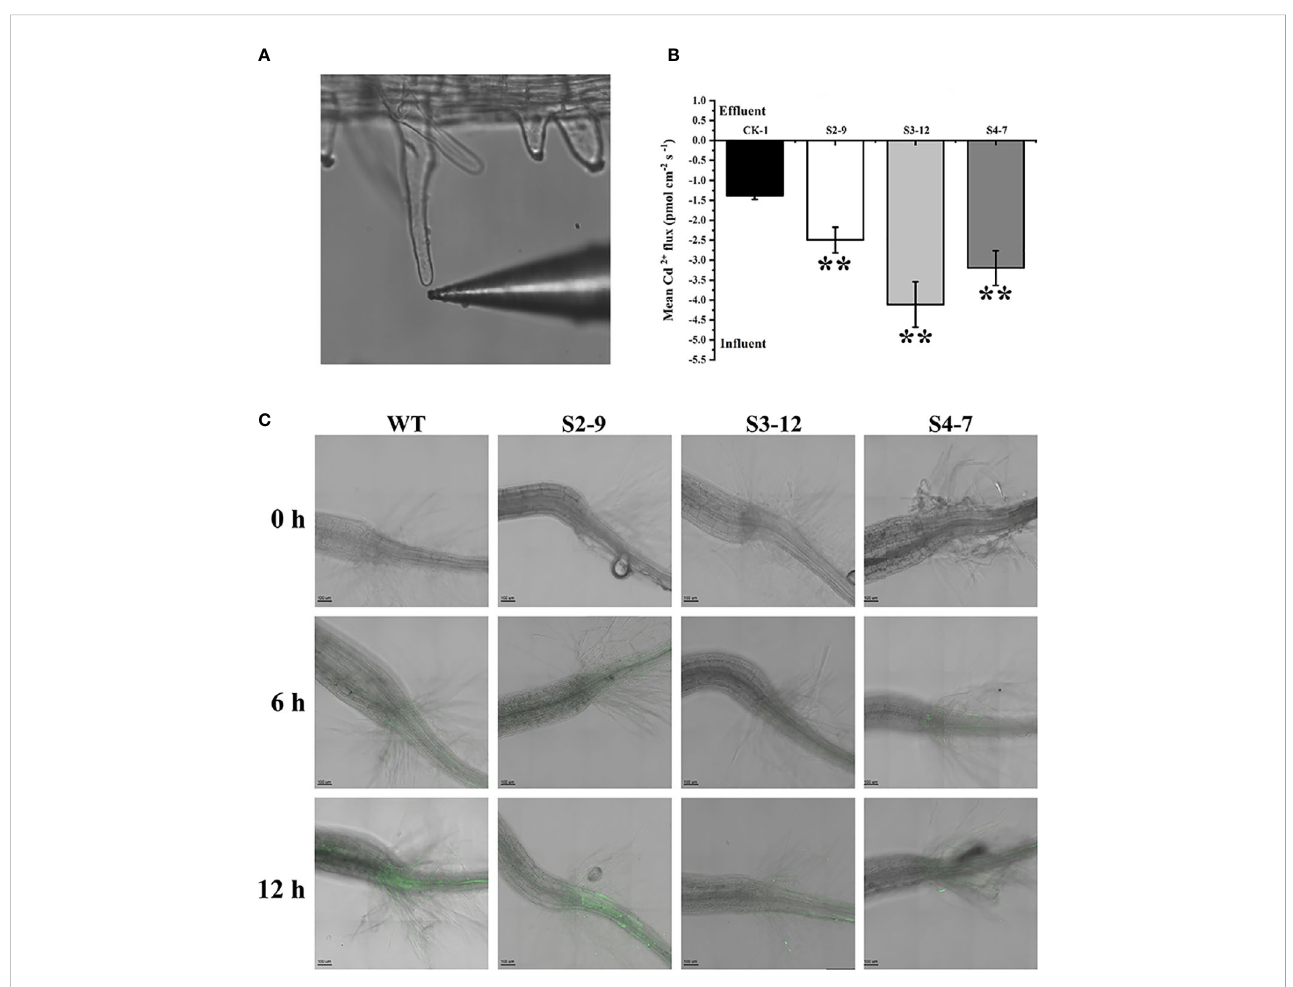
FIGURE 4 Cd 2+ fl uxes and free Cd 2+ detection in TaSBP-A overexpressed Arabidopsis root hairs. (A) A representative root hair and the Cd 2+ -selective microelectrode used. (B) The mean Cd 2+ fl uxes in the root hair was measured for 30 min after exposure to 30 m M Cd 2+ by using a noninvasive micro- test technique. The data are indicated as mean± SD from the three biological replicates. All data were statistically analyzed using a one-way ANOVA. The asterisks represent signi fi cant differences at different levels (* p < 0.05; ** p < 0.01; *** p < 0.001). (C) Micrographs of seedling roots from WT and overexpressed lines exposed to 150 m M Cd for different treatment times. Plant roots were pre-treated with 150 m M CdCl 2 for 0 h (control), 6 h and 12 h on a 1/2-MS plate and loaded with Leadamium ™ Green AM dye for 60 min. All images were taken by a confocal laser scanning microscope (Leica TCS SP5, Germany). Green fl uorescence indicates the binding of the dye to